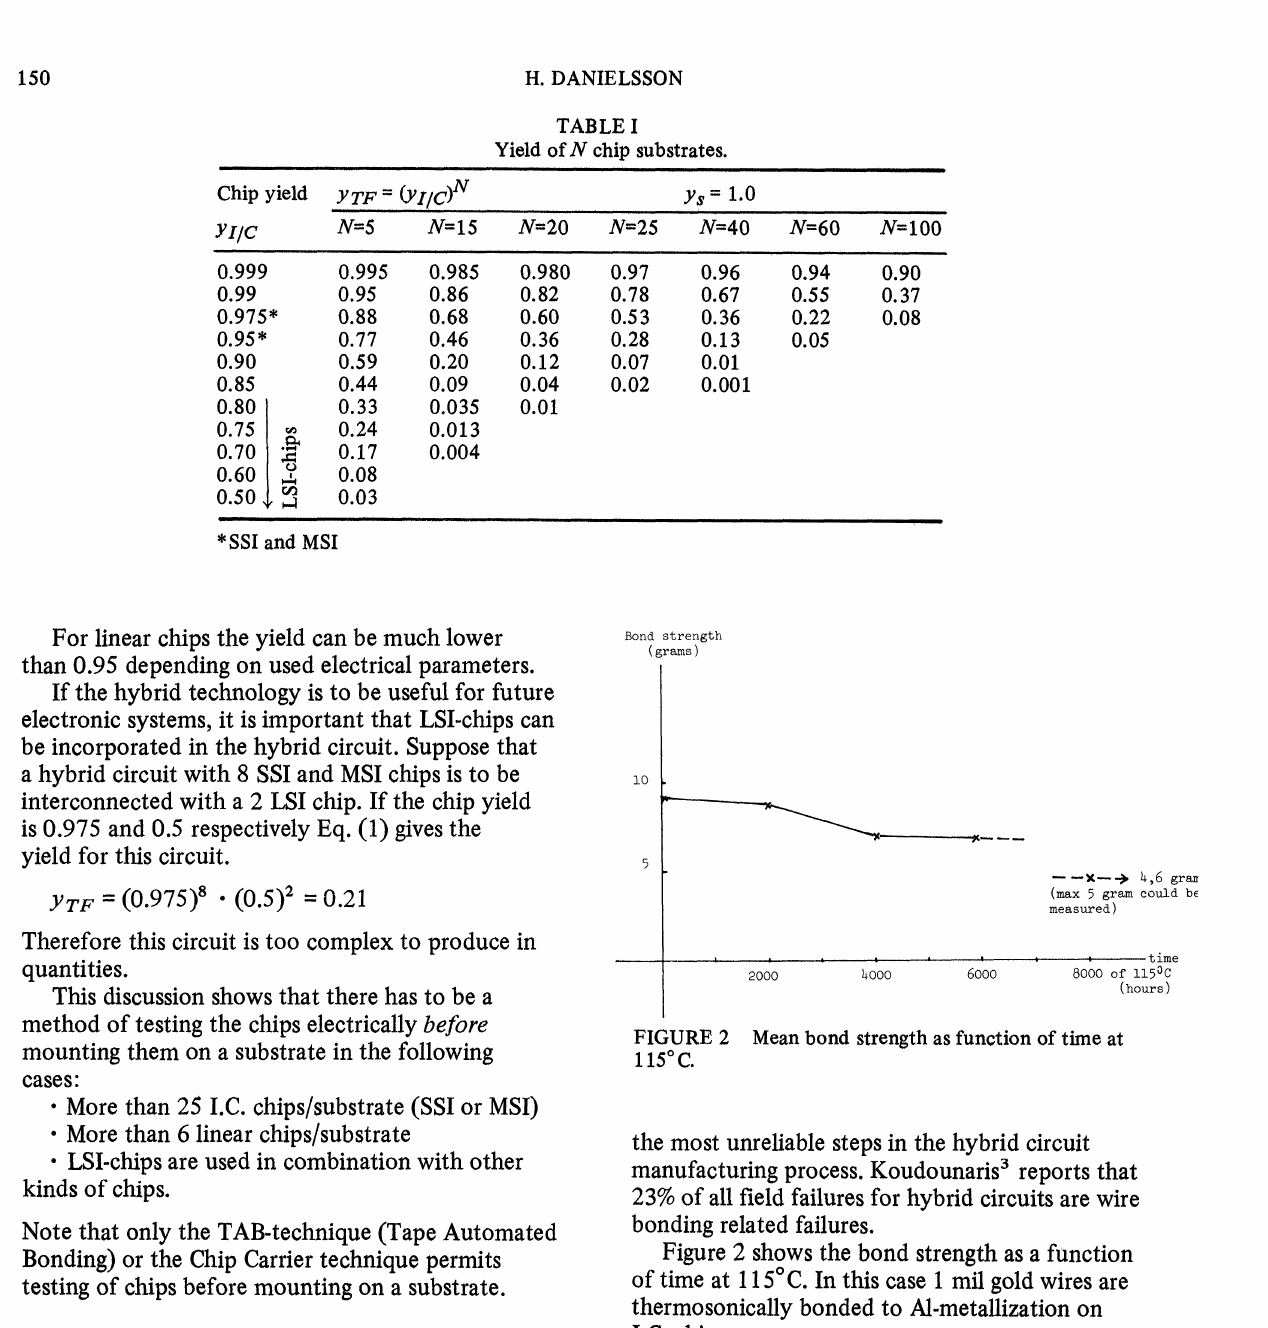
FIGURE 2 Mean bond strength as function of time at